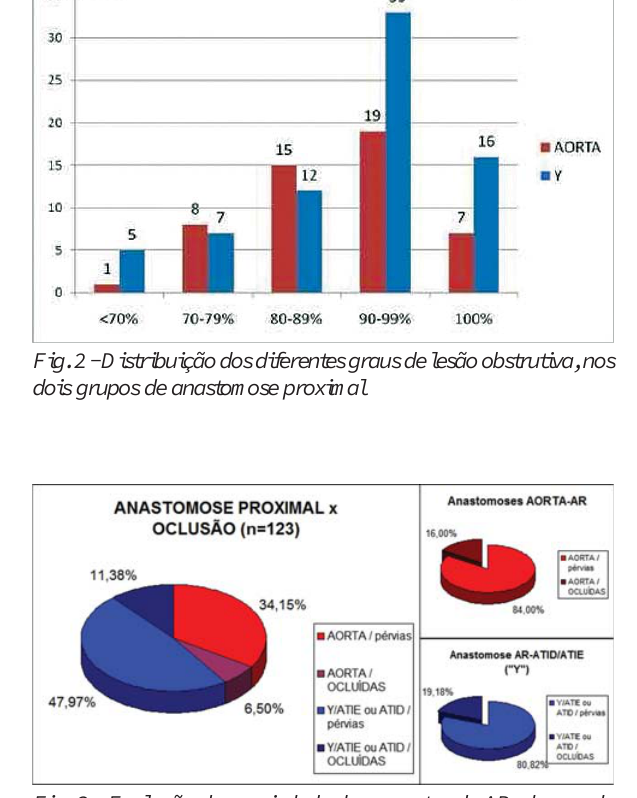
Fig. 3 - Evolução da perviedade dos enxertos de AR, de acordo com a anastomose proximal